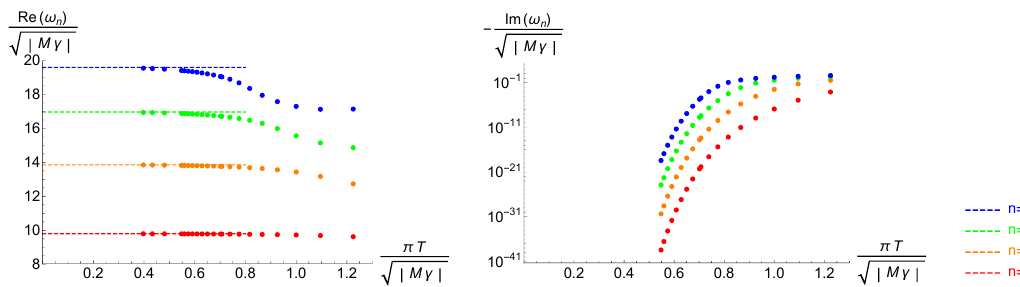
Figure 3 . The real (left) and imaginary (right) components of the quasi normal frequencies as a function of temperature. As the temperature decreases the quasi normal frequencies approach the p p p p j M(cid:13) j = 2 zero temperature value of ! n = 6 ~(cid:10) = 4 6 n + 1 with n = 0 ; 1 ; : : : . Convergence to the zero temperature value is slower for higher modes. Data in this plot is identical to the one in (cid:12)gure